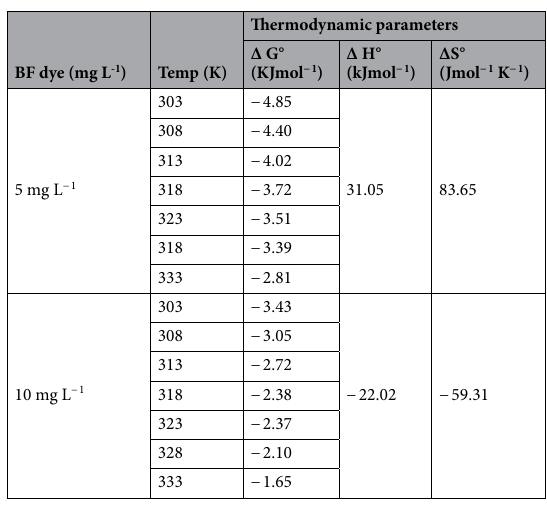
Table 7. Thermodynamic parameters for biosorptive removal of BF dye by Gel@GO-F-ZrSiO 4 @Gel.